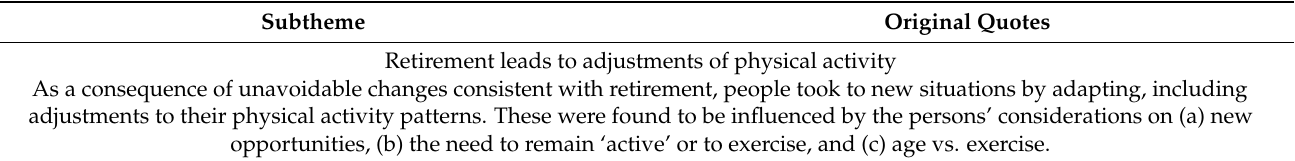
Table A3. Subthemes for second